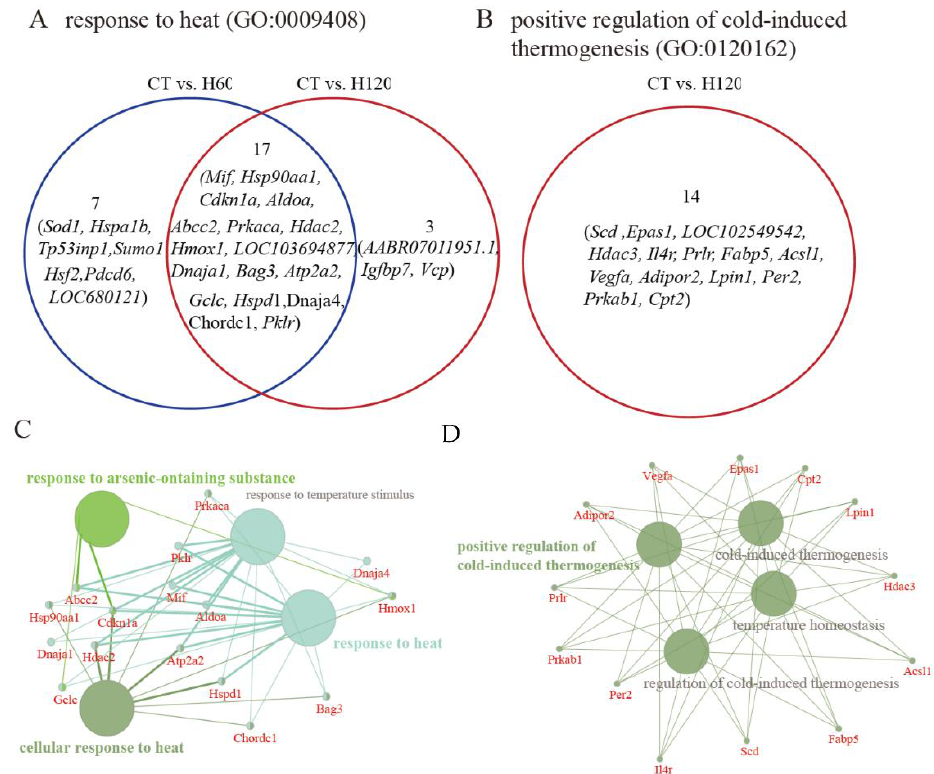
Figure 3. Genes of liver involved in the heat stress process and their functional annotations. ( A ) Venn diagram of genes that engaged in terms of response to heat (GO: 0009408). ( B ) Venn diagram of genes that engaged in terms of the positive regulation of cold-induced thermogenesis (GO: 0120162). ( C ) The functional annotation of genes that were significantly clustered in response to heat and were shared between the CT vs. H60 and CT vs. H120 comparisons. ( D ) The functional annotation of genes in the CT vs. H120 comparison of the liver that were significantly clustered in the positive regulation of cold-induced thermogenesis. Only the GO-BP terms with p ≤ 0.05 are shown in colored words. In adrenal glands, 114, 649, and 567 BP terms were significantly (FDR ≤ 0.05)